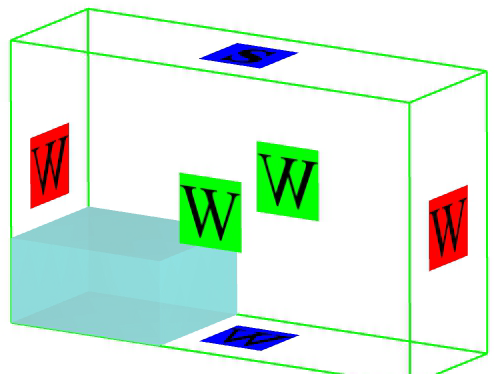
Fig. 4. Boundary conditions for dam-break model (in verification